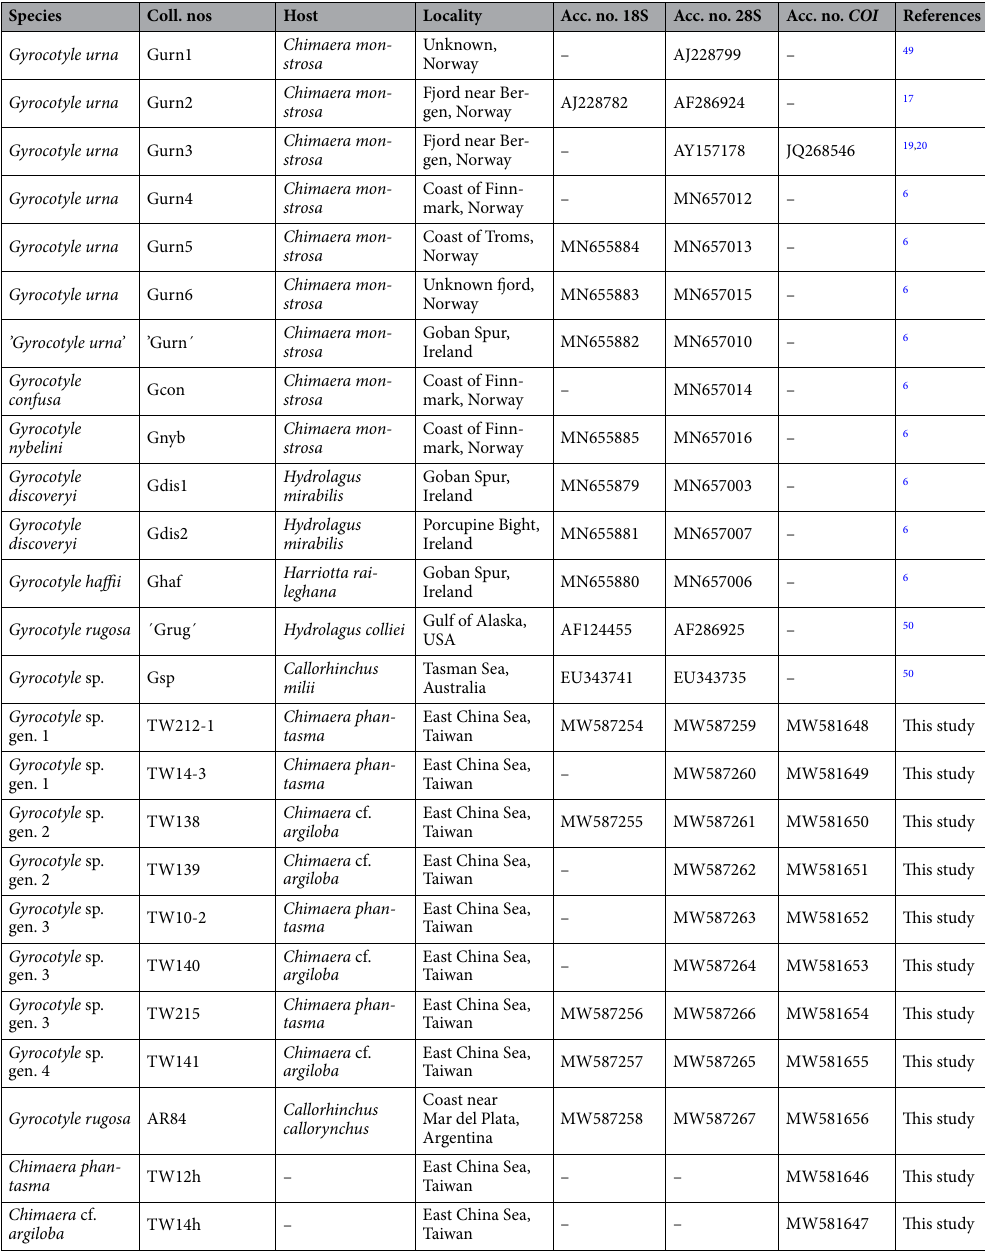
Table 1. List of isolates with GenBank accession numbers of 18S rRNA, 28S rRNA and cytochrome c oxidase subunit 1 ( COI ) genes of Gyrocotyle spp. and COI gene of Chimaera spp. used in genetic